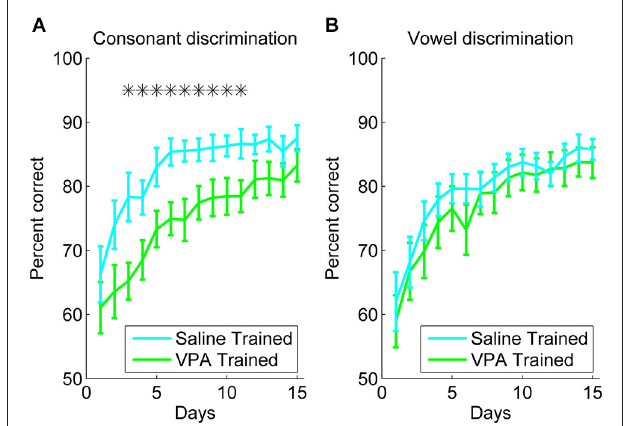
FIGURE 1 | VPA exposed rats are impaired at consonant discrimination, but not vowel discrimination. (A) Consonant discrimination time courses for VPA exposed ( n = 10 rats; green line) and saline exposed rats ( n = 10 rats; cyan line). Error bars indicate s.e.m. across rats. Stars indicate time points where VPA exposed rats perform significantly worse than saline exposed rats ( p < 0.05). (B) Vowel discrimination time courses for VPA exposed ( n = 10 rats) and saline exposed rats ( n = 11